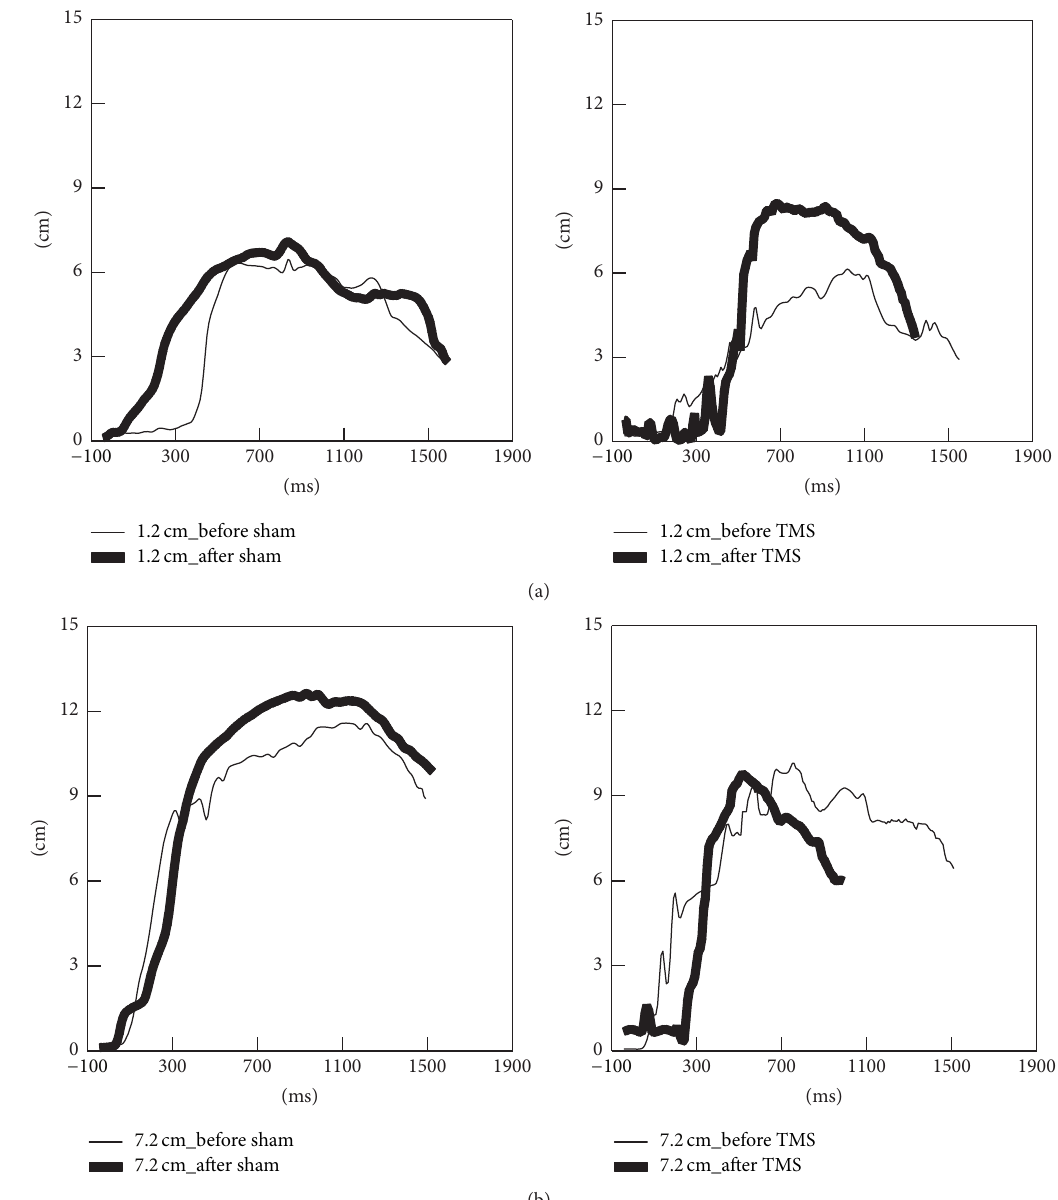
Figure 4: Representative data for grasp aperture during reach-to-grasp actions to the small object (a) and the large object (b) following sham (left) and real rTMS conditions (right). The thinner trajectories represent baseline performance; the thick trajectories represent performance after each TMS